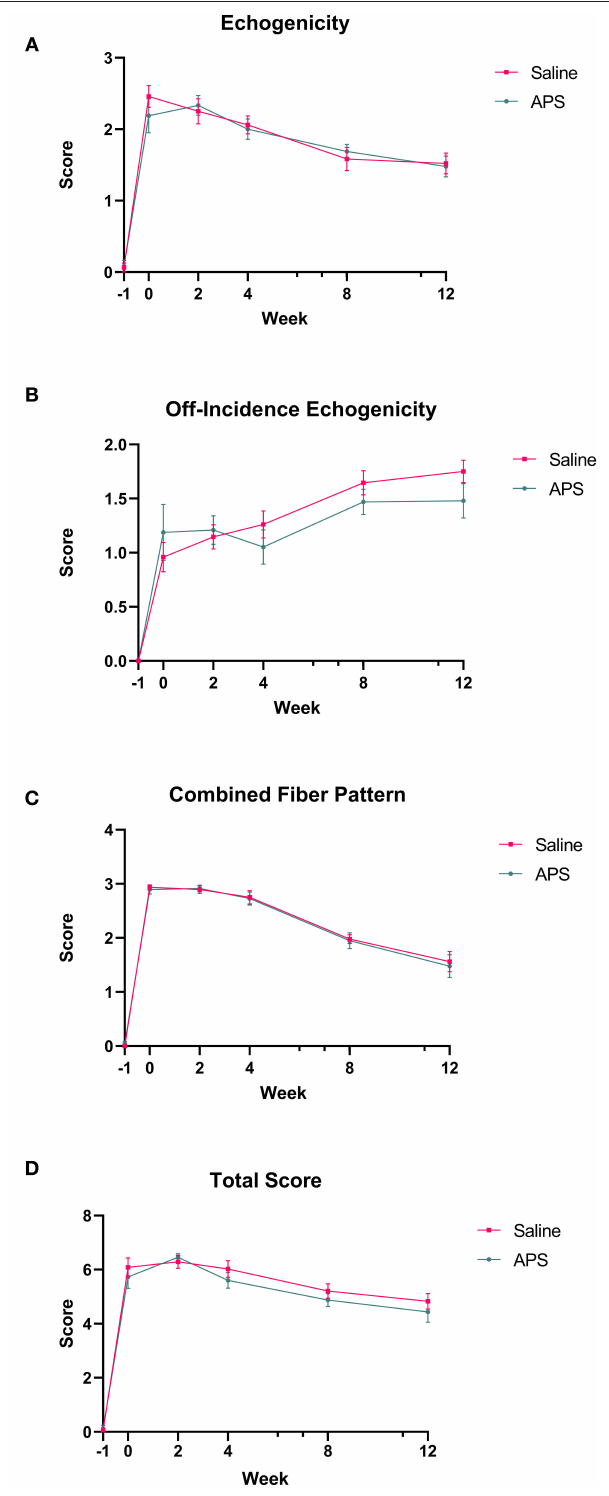
FIGURE 2 | Mean ( ± SEM) scores for (A) tendon echogenicity, (B) off-incidence tendon echogenicity, (C) tendon fiber pattern, and (D) total ultrasonographic score at the maximal injury zone (14–18cm DACB) at 0, 2, 4, 8, and 12 weeks following intra-lesional injection of saline or APS ( n =